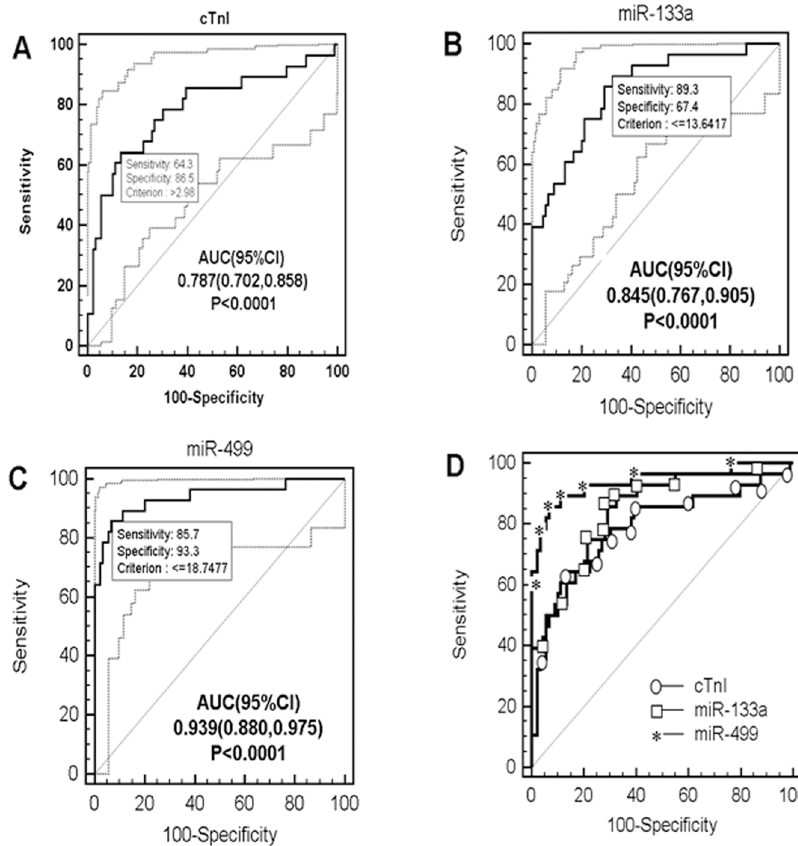
Figure 4. Receiver operating characteristic(ROC) curves for the identification of PMI at 6 hours after CABG. The thin diagonal line is the Null Hypothesis: True area=0.50. A, B and C panels show the ROC and AUC values of cTnI, miR-133a and miR-499, respectively, as thick solid lines. The dotted lines show the 95% CI of ROC curves. The highest AUC was calculated from miR-499 (0.939, p , 0.0001). (A) cTnI ( . 2.98 ng/ml) had a sensitivity of 64.3% and specificity of 86.5% for the identification of PMI. (B) miR-133a ( D Ct , 13.6417) had a sensitivity of 89.3% and specificity of 67.4% for the identification of PMI. (C) miR-499 ( D Ct , 18.7477) had a sensitivity of 85.7% and specificity of 93.3% for the identification of PMI. (D) Comparison of ROC curves of cTnI( ellipses ), miR-133a( rectangles ) and miR-499 ( asterisks ) at 6 h postoperatively. Abbreviations: AUC=area under the curve; Ct=cycle threshold; cTnI=cardiac troponin I; PMI=perioperative myocardial infarction.